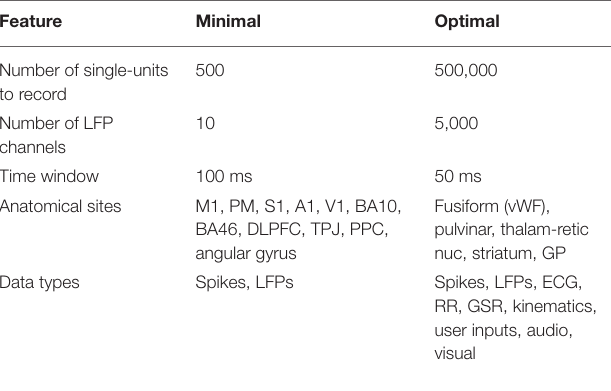
TABLE 1 | Hypothetical minimal constraints for chronically implanted neural sensor-actuators to link the brain to a whole brain emulation. Feature Minimal